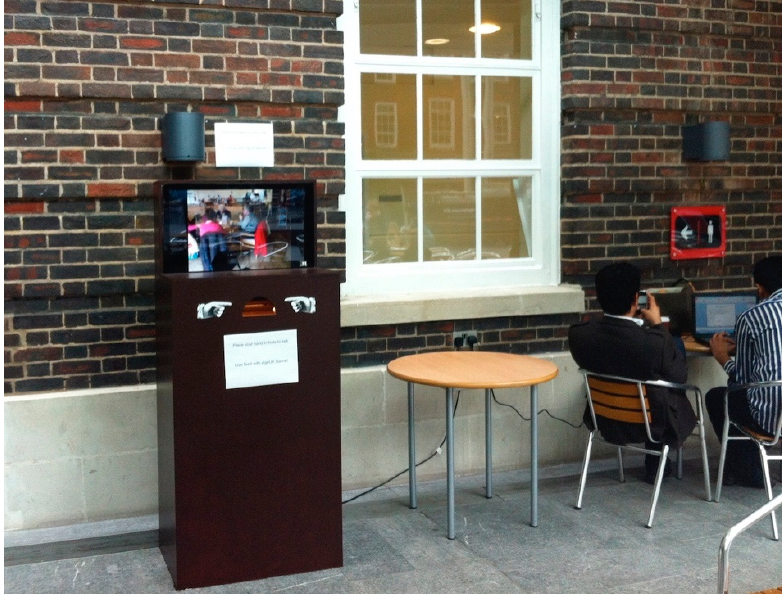
Figure 2. The TT kiosk at the university’s location in the main entrance hall. The TT provides a view into the day centre. Permission granted by Dr Marianne Markowski.